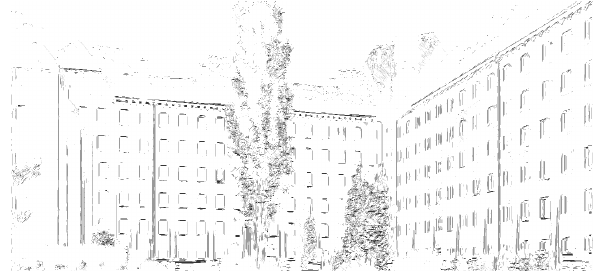
Figure 9: Edges detected from the re-projected point cloud data of building H¨ulssebau.